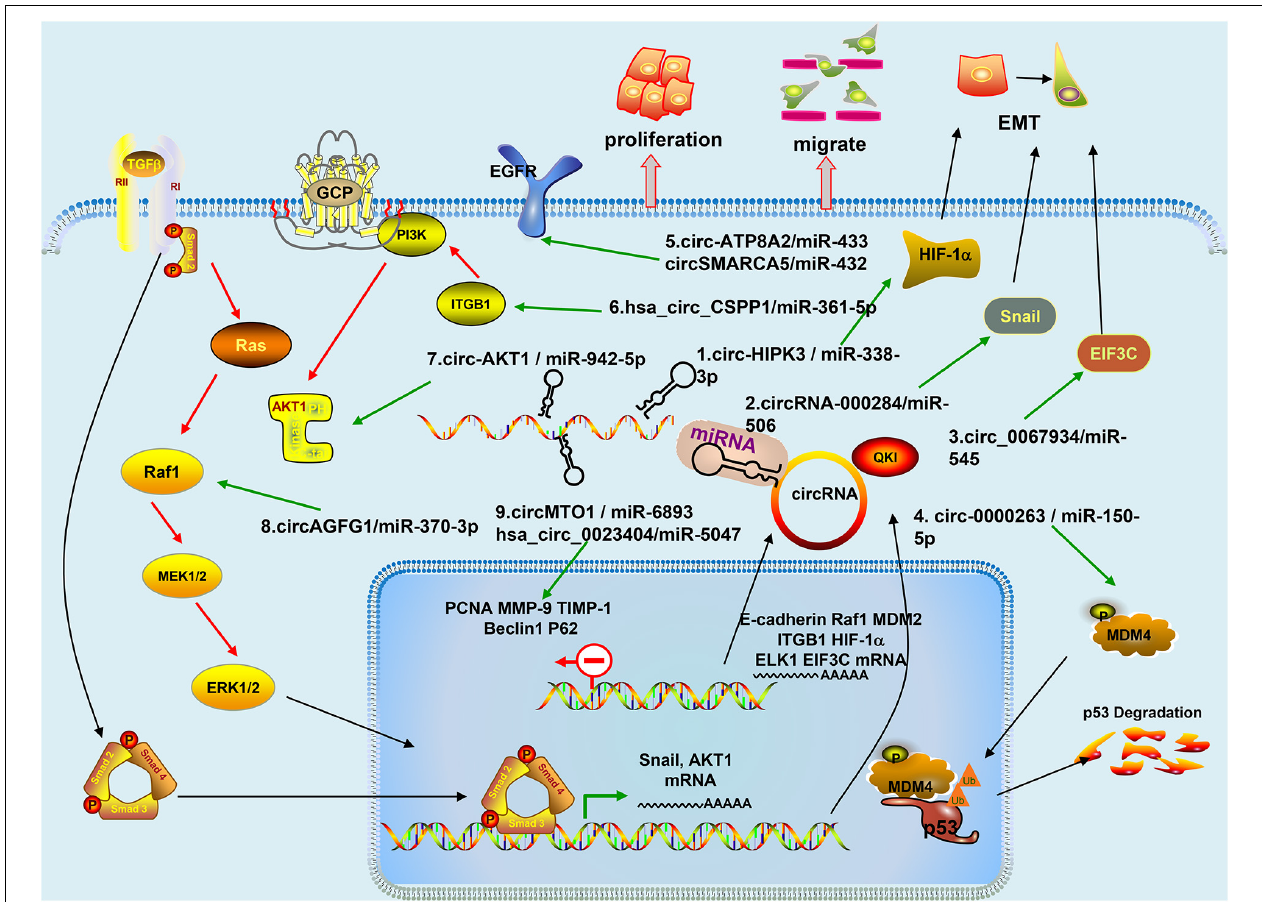
FIGURE 2 | Mechanism of circRNAs in Cervical Cancer: (1) Circ-HIPK3 acts as a competing endogenous RNA of miR-338-3p, via regulating HIF-1 α mediated EMT; (2) CircRNA-000284 suppresses the expression of Snail-2 via sponging miR-506; (3) Circ_0067934 modulates EIF3C by sponging miR-545; (4) Circ-0000263, as a competitive endogenous RNA, regulates MDM4 expression by sponging miR-150-5p and may play an important role affecting the expression of p53 gene; (5) Circ-ATP8A2 sponges miR-433 to release its suppression on EGFR expression. CircSMARCA5 modulates miR-432 via the ERK signaling pathway; (6) Hsa_circ_CSPP1 regulates miR-361-5p/ITGB1 in the PI3K-Akt signaling pathway; (7) CircRNA-AKT1 sequesters miR-942-5p to upregulate AKT1; (8) CircAGFG1 enhances the activity of RAF/MEK/ERK pathway by sponging miR-370-3p and further regulating RAF1; and (9) CircMTO1 directly interacts with miR-6893 and their inhibitor enhanced Beclin 1 expression and downregulated p62 level. Hsa_circ_0023404 knockdown can also promote p62 protein levels and attenuate Beclin 1 level.